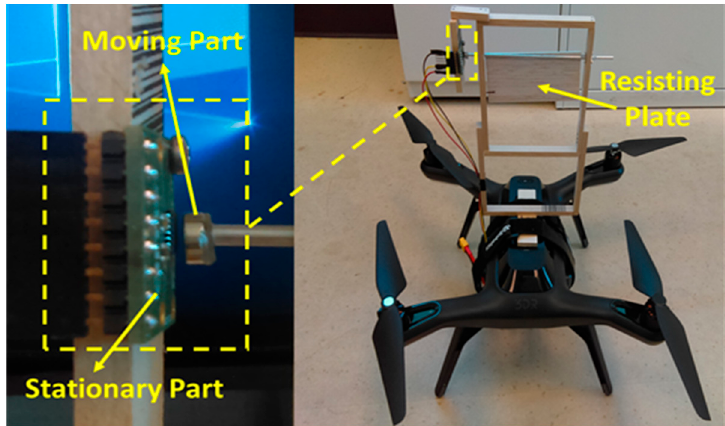
Figure 7. Air-Odo System attached to the top of the quadcopter.